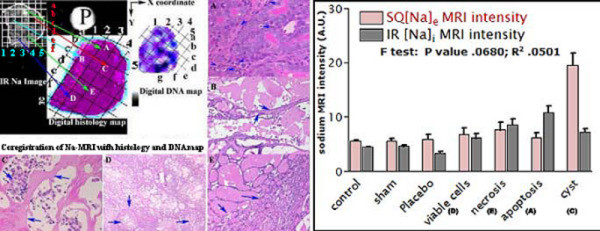
The figure shows the stereotactic co-registration method of IR sodium tumor image, its counterpart histology and DNA ploidy map at different x- and y- co-ordinate locations shown as 1–5 and a-g for different areas. Notice the matched tumor delineated areas on three digitized images and corresponding features shown with arrows for high % apoptosis (A), high % EC volume (B), cyst (C), % viable cells and proliferation (D), % necrosis (E) in high power fields. The tumor IR sodium MR image appears hypointense for cyst and high EC regions and hyperintense for active proliferation while isointense for necrosis. On right panel, sodium signal intensities are shown for 100 mM SQ sodium phantom and 10 mM IR sodium phantom along with relative MRI signal intensities in the different tumor regions.